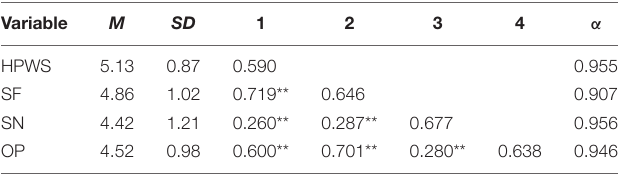
TABLE 2 | Mean value, standard deviation, correlation coefficient, square root of AVE.